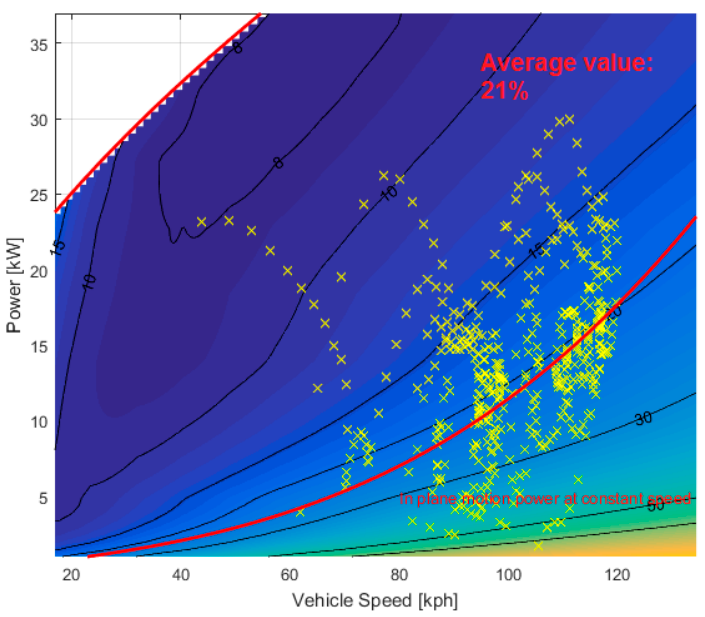
Figure 15. Highway mission work points on the electrical-loss (%) contour map.